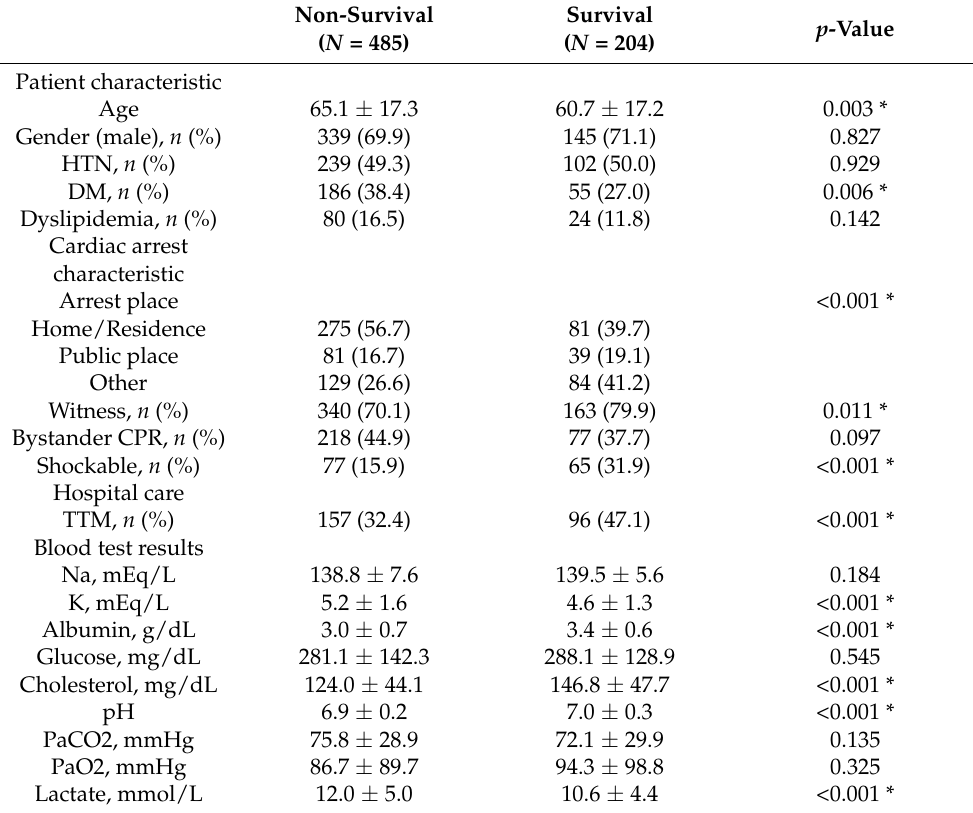
Table 2. Baseline characteristics of out-of-hospital cardiac arrest patients with survival to discharge.